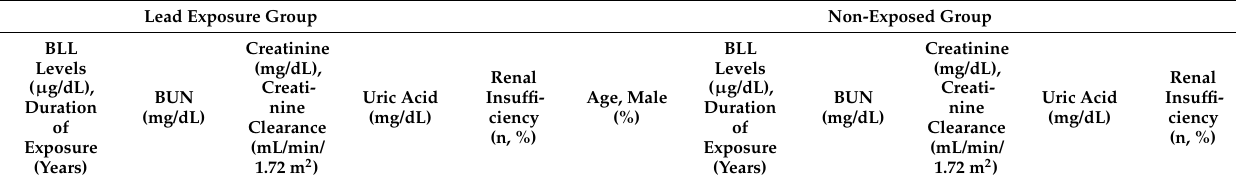
Table 1. Characteristics of the included